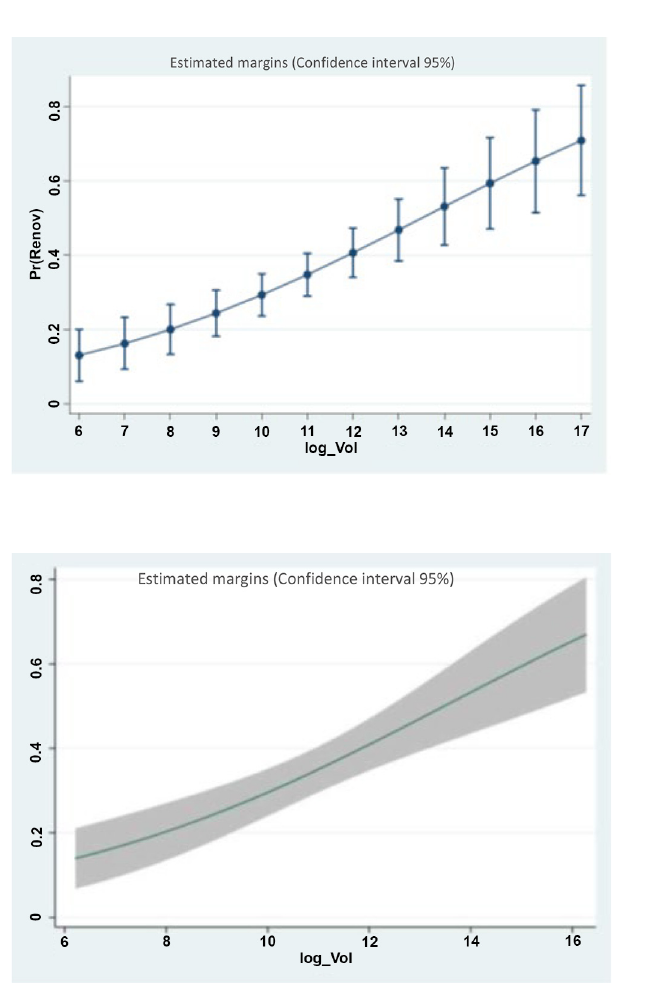
Figure 3. Probability to